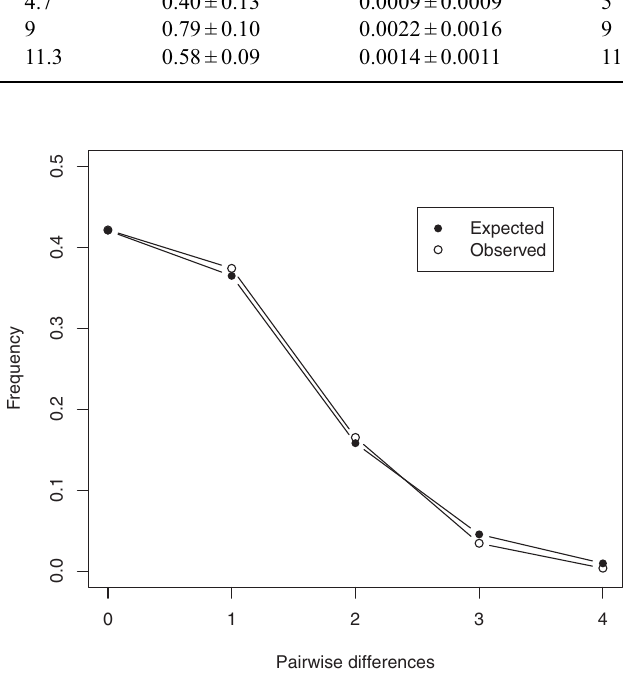
Fig. 3. Mismatch Distributions, based on 40 sequences (589 bps) of mitochondrial CO1 barcode of Parapenaeopsis sculptilis from Bangladesh. The Sudden Expansion Model was used to obtain the expected